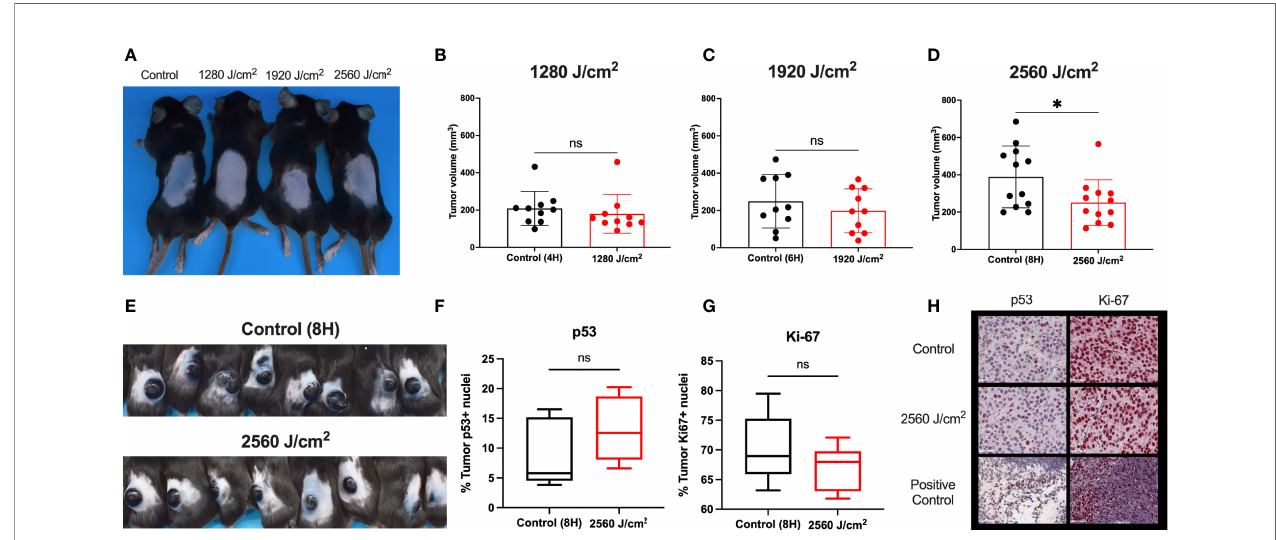
FIGURE 5 | RL safety and ef fi cacy. (A) C57BL/6 mice without tumors were treated with RL at 1280, 1920, and 2560 J/cm 2 for 15 days (n=3). Mice had no increase in rectal temperature, and the skin was non-in fl amed and non-erythematous compared to non-RL treated mice. (B) C57BL/6 Mice were injected with 3 x 10 5 melanoma cells and irradiated daily with 1280 J/cm 2 (n=10), (C) 1920 J/cm 2 (n=10), and (D) 2650 J/cm 2 RL (n=12). Volume was calculated using the formula Volume = 0.52 x length x width x depth. (E) Representative mice with tumors (n=8) in the control group and 2560 J/cm 2 RL group on day 15. (F) Quanti fi cation of p53+ (n=5) and (G) Ki- 67+ (n=5) staining nuclei in from control (8H) and 2560 J/cm 2 treated tumors. Quanti fi cation of staining was performed using Indica HALO software. (H) Representative images of p53+ and Ki-67+ staining in tumors. Cephalic (embryonic day 14) and spleen positive control sections are provided for p53 and Ki-67. Excised tumor volumes and IHC staining intensity for RL-treated mice were compared to matched controls by a two-tailed T-test (p<0.05). *denotes p<0.05. ns denotes not signi fi